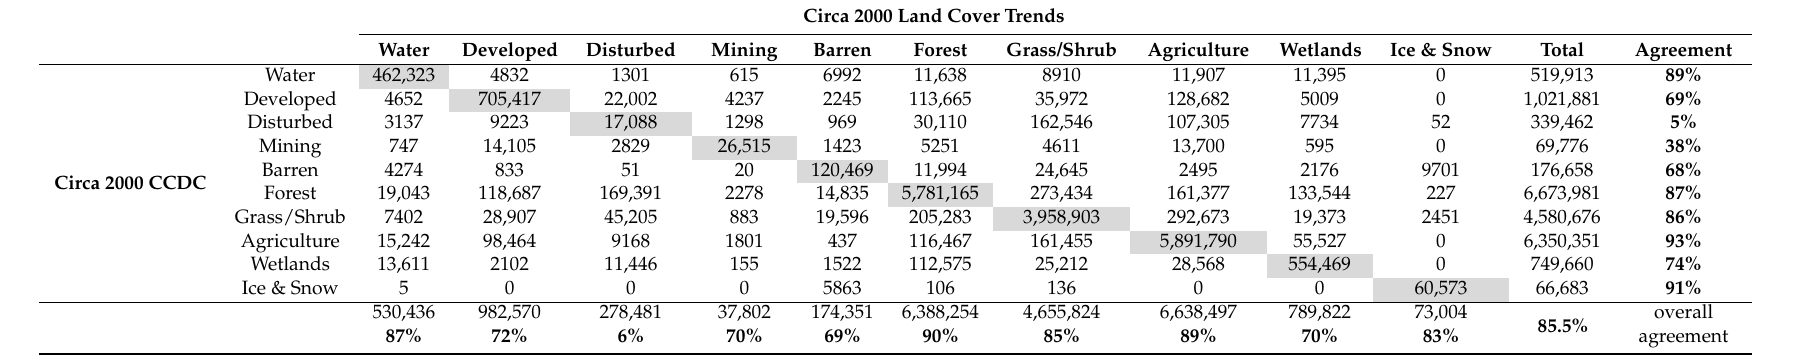
Table 2. Confusion matrix for all pixels from all path/rows for the 2000